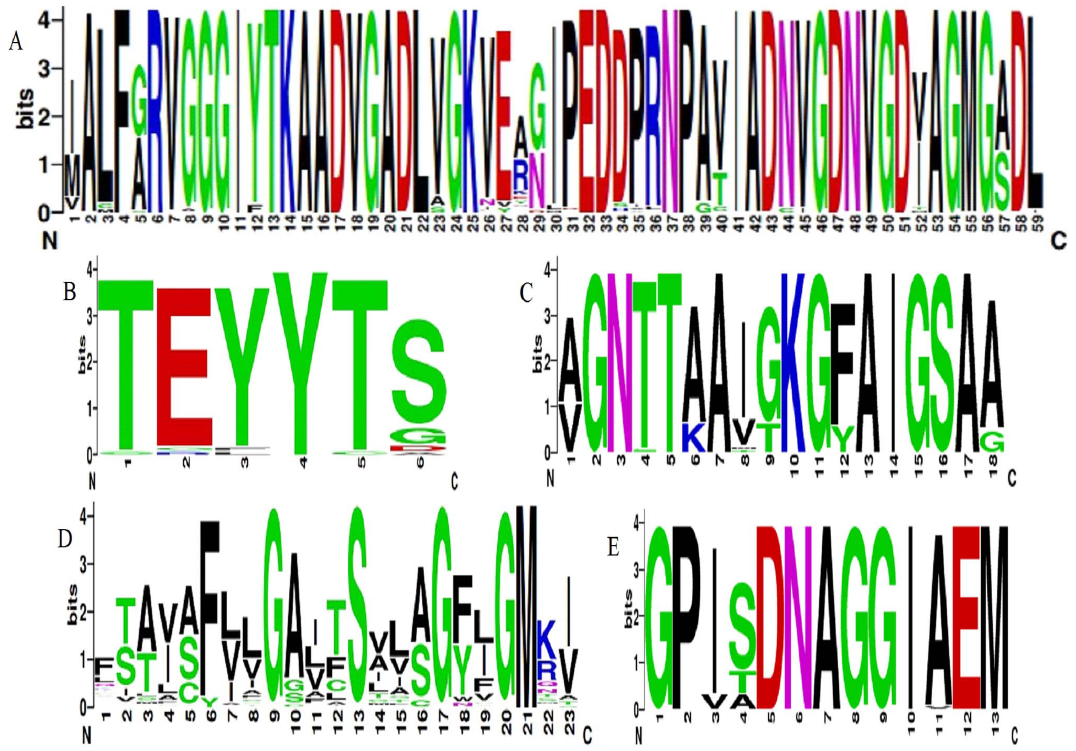
Figure 4. Consensus sequences of the conserved domains of H + -PPase that were isolated from 7 eremophytes and more than 240 H + -PPases from NCBI. The sequences IALFGRVDGGIYTKAADVGADLVGKVERNIPEDDPRNPAVIADNVG DNVGDIAGMGSDL (A), TEYYTS (B), and AGNTTAAIGKGFAIGSAA (C) are previously identified conserved domains [5,26]. The sequences FTAVAFLLGGITS LISGFLGMKI (D) and GPISDNAGGIAEM (E) are new possible motifs, according to conserved sequence and structure.